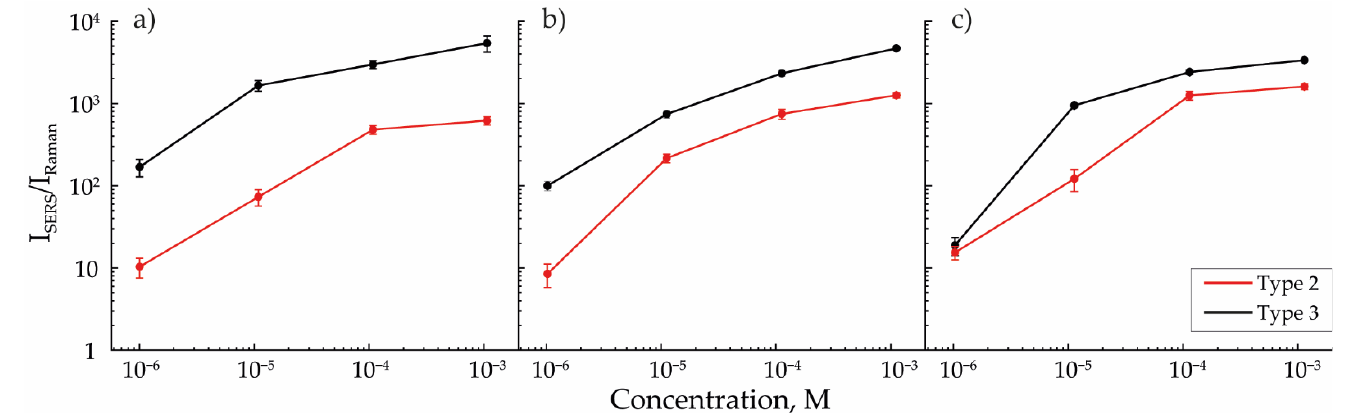
Figure 5. Efficiency of MB detection for SERS arrays of types 2 and 3, formed with aerosol flows of ( a ) 50, ( b ) 200, and ( c ) 400 mL/min. ( a ) 50, ( b ) 200, and ( c ) 400